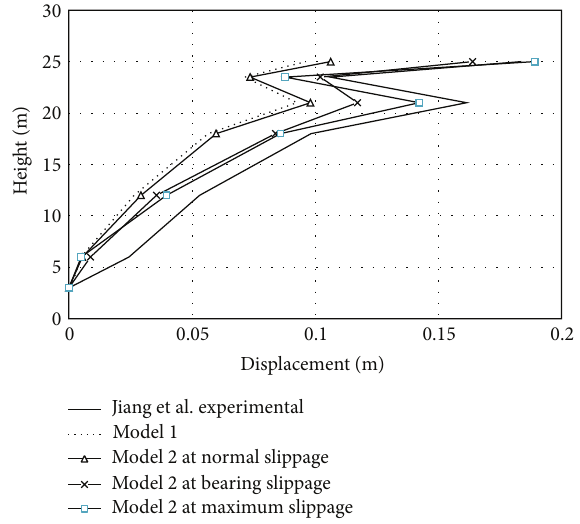
Figure 22: Tower 2 longitudinal displacement at 95% load.